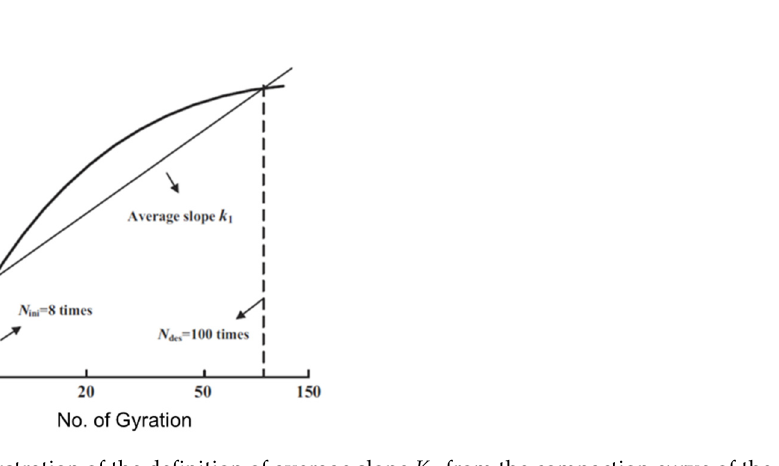
Figure 12. Illustration of the definition of average slope K 1 from the compaction curve of the degree of compaction versus the number of gyrations [46].